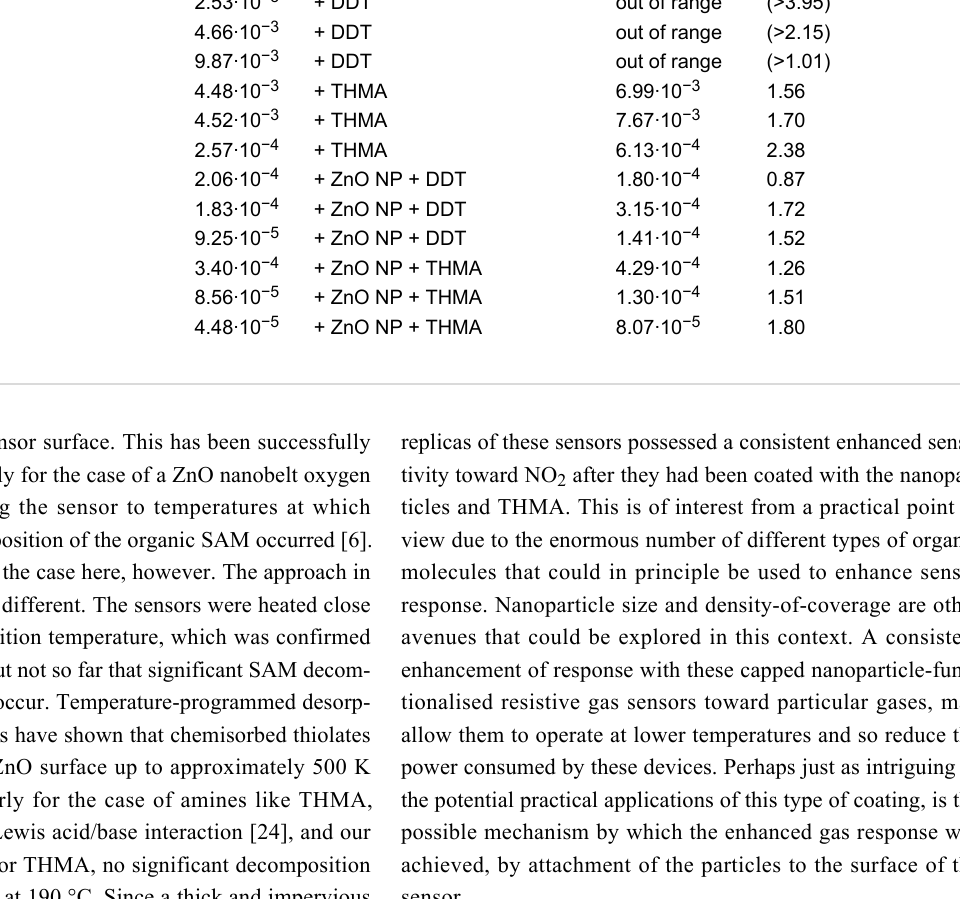
Table 1: Average response of all ZnO NW samples upon exposure to 2 ppm NO 2 . code before